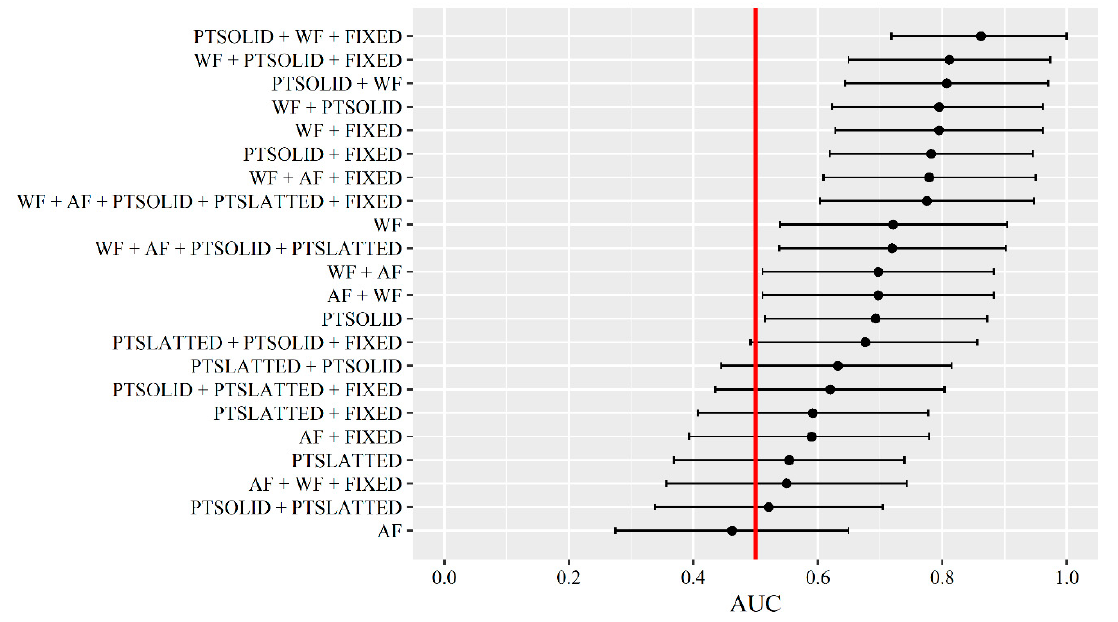
Figure 3. AUC (area under the ROC curve) with 95% confidence intervals (CI) for each Bayesian ensemble of models on water flow (WF), activation frequency (AF), pen temperature above the solid floor (PTSOLID), pen temperature above the slatted floor (PTSLATTED) and the fixed probability (FIXED) for the alarm type UNTIMED (day-1, day-2 and day-3). If the CI does not overlap with the red vertical line, the final updated model has a predictive performance better than random guessing.